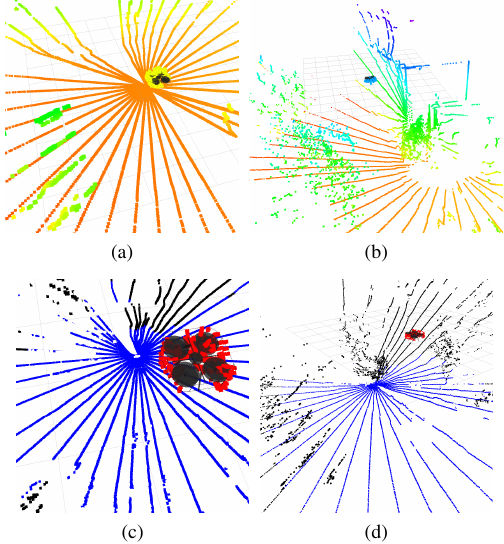
Figure 3: Examples of acquired laser scans with points colored by height (a+b) and laser-based ground plane and height estima- tion (c+d): After filtering out measurements on the robot (red points), we estimate the dominant horizontal plane (blue points), and compute its distance to the robot as an height estimate. Ob- stacles other than the ground are colored black.